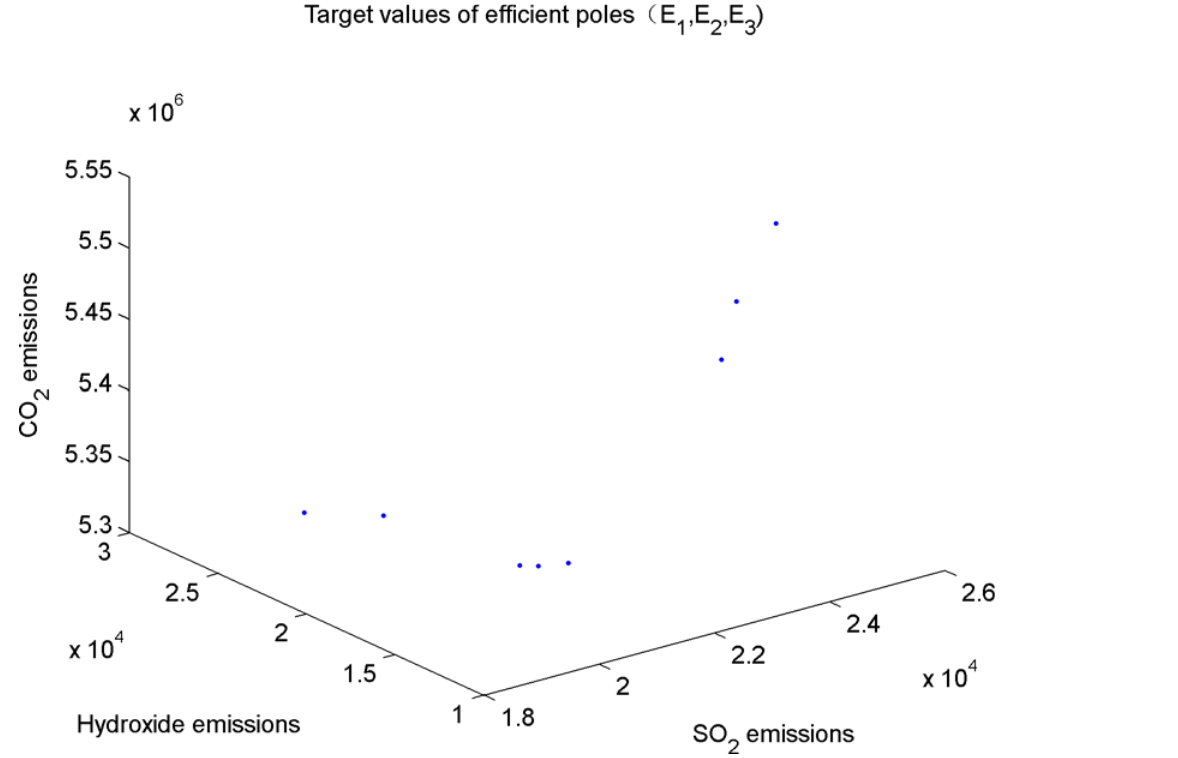
Fig 3. Target values of all efficient solutions.